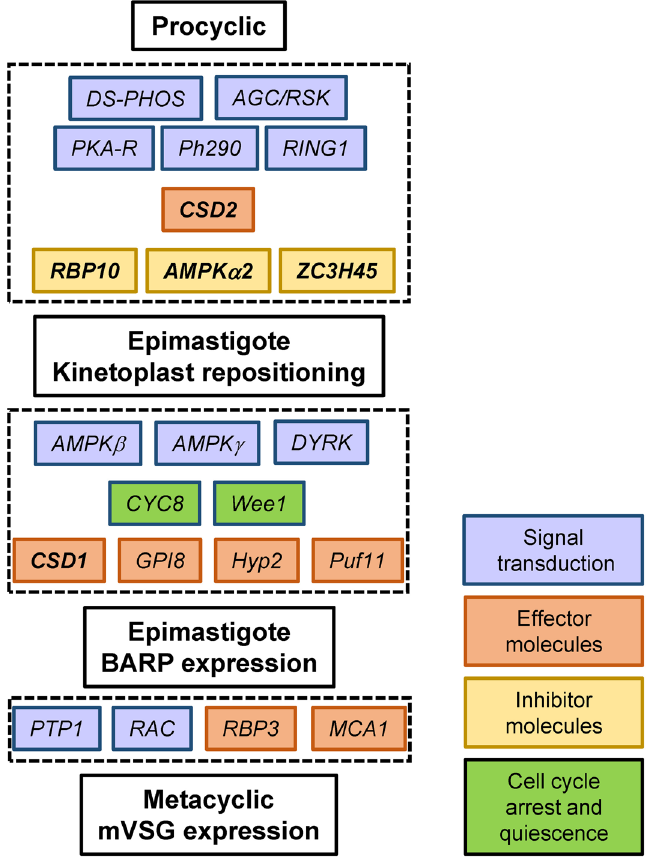
Figure 5. Schematic of identified components regulating metacyclogenesis in T. brucei . The order of components at each step and the position of pathway inhibitors is unknown. Those in bold italics were analyzed by